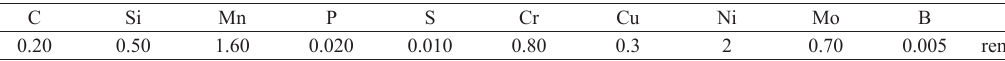
Table 1. Substance composition of Strenx steel.